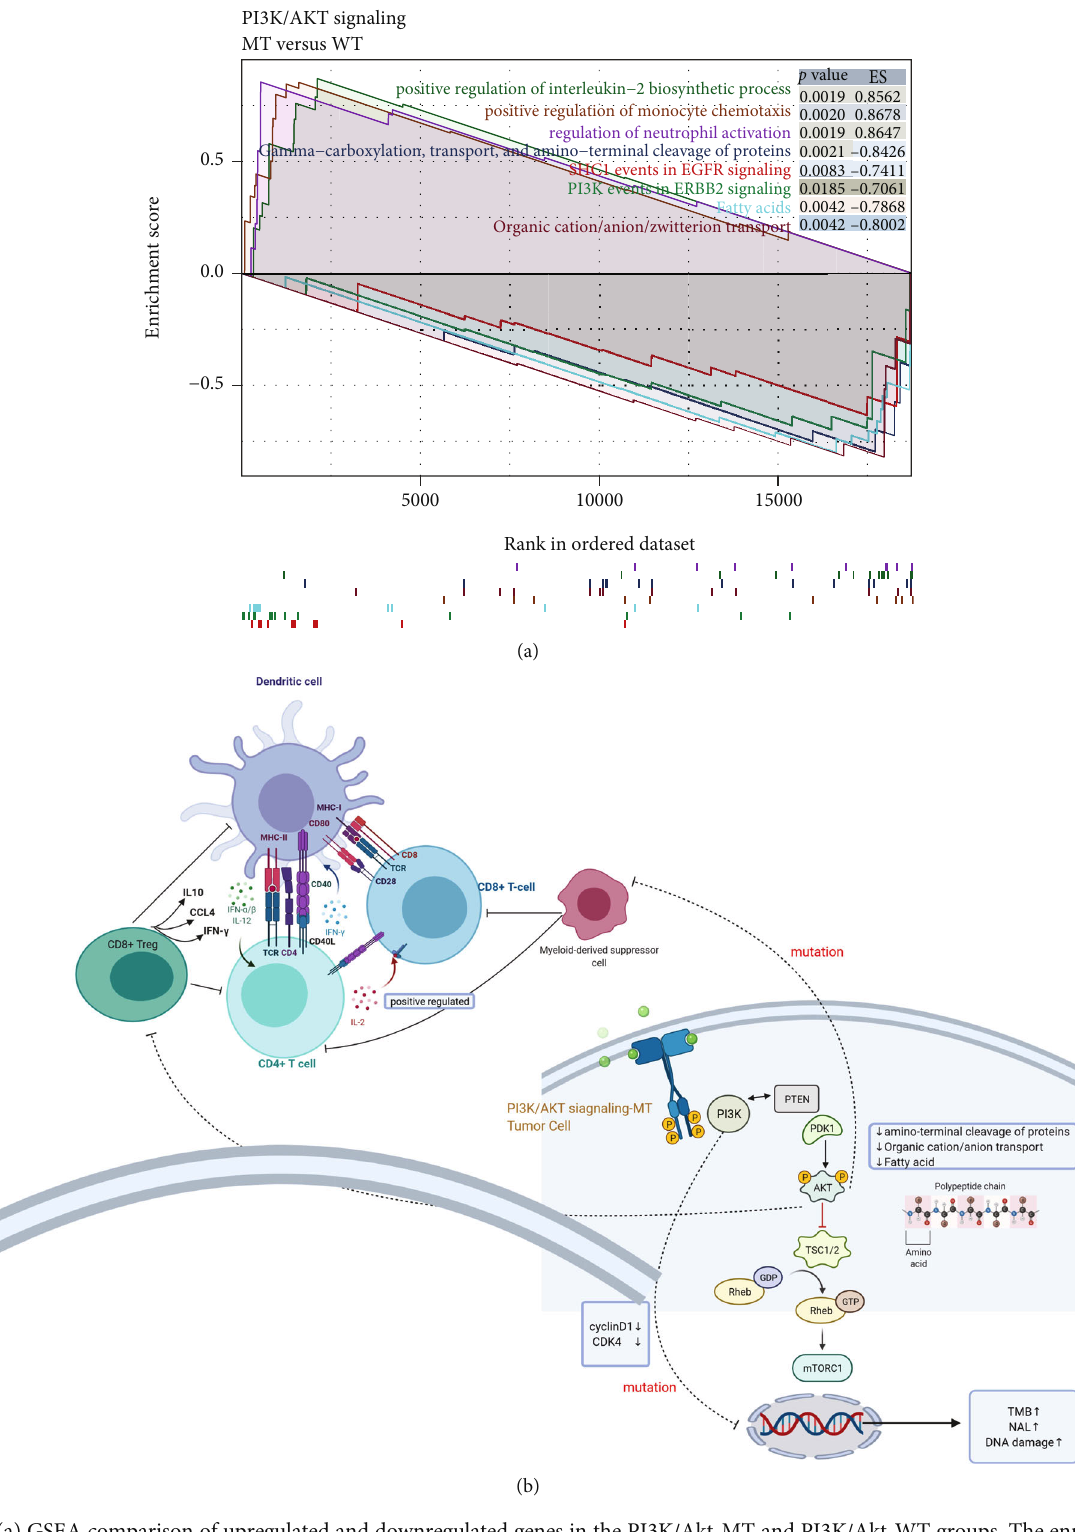
Figure 5: (a) GSEA comparison of upregulated and downregulated genes in the PI3K/Akt-MT and PI3K/Akt-WT groups. The enrichment score greater than 0 indicates that the pathway is upregulated in the PI3K/Akt-MT group, and the enrichment score less than 0 indicates that the pathway is downregulated in the PI3K/Akt-MT group. The color of the pathway name is consistent with the color of the broken line in the fi gure; P value less than 0.05 is statistically signi fi cant. (b) The potential mechanism of PI3K/Akt-MT patients with colorectal cancer receiving ICI had a better